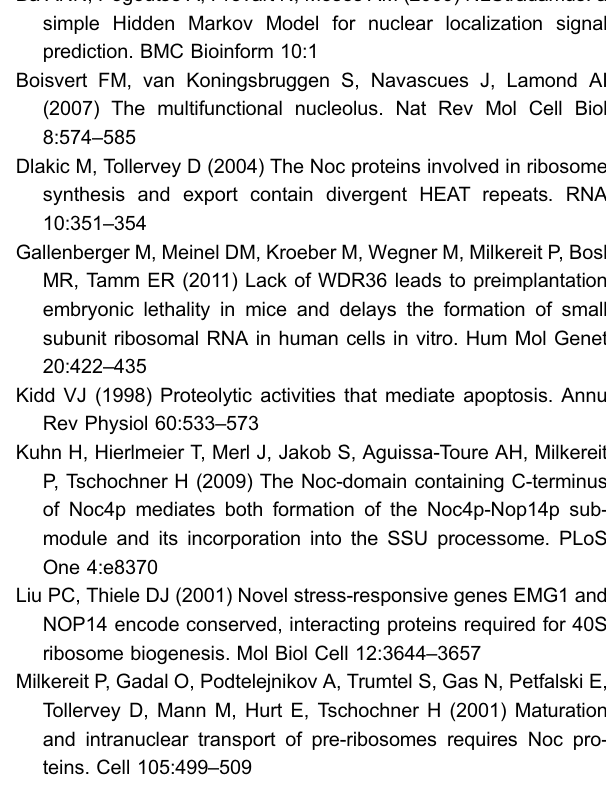
Figure 2. Noc4l de fi ciency results in early embryonic lethality . (A) Two-cell embryos genotyped using nested PCR. PCR products (1 – 13 of 114) from 2-cell embryos are